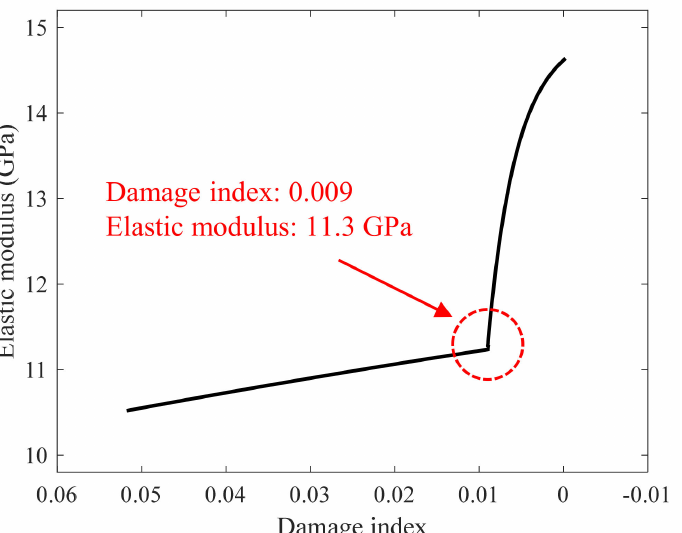
Figure 11. Correlation between the damage index of a saw-cut area and elastic modulus of